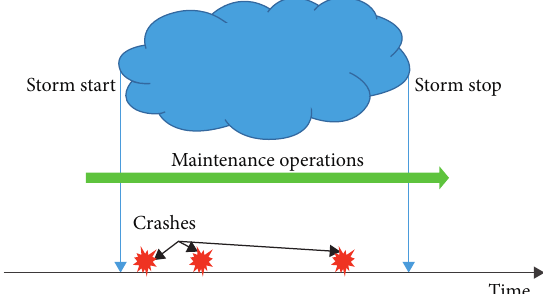
Figure 1: Associating multiple data sources related to a winter storm. Table 1: Combined dataset variable